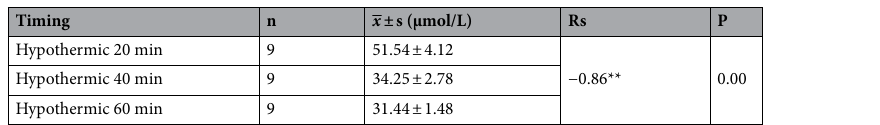
Table 6. GABA values of brain extracellular fluid in different hypothermic perfusion time groups (μmol/L). There was a significant correlation between different hypothermic perfusion times and GABA values. **When the confidence (bilateral) is 0.01, the correlation is significant.